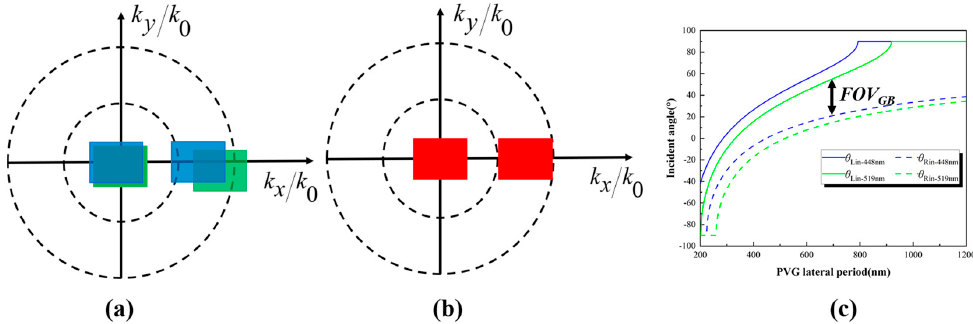
Figure 4. ( a ) The k-vector diagram for blue and green sharing a layer of the waveguide. ( b ) The k-vector diagram for red with a separate layer of the waveguide. ( c ) Plot of the relationship between Λ x and incident angle ranges at the G (519 nm) and B (448 nm) bands in the common waveguide